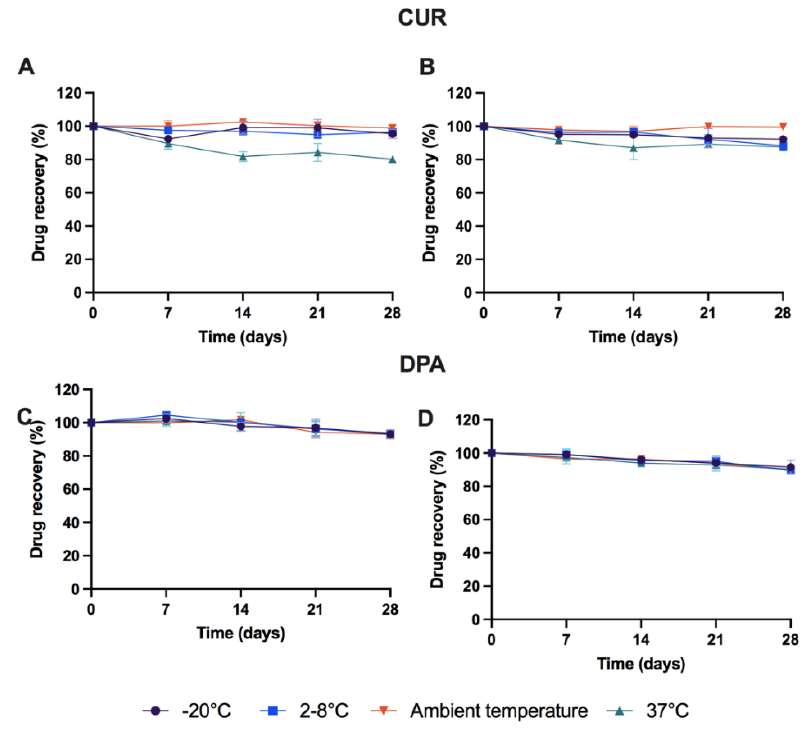
Figure 2. Percentage recovery of CUR: ( A ) PBS pH 7.4 containing 0.5% w / v Tween ® 80; ( B ) PBS pH 7.4 containing 0.5% w / v Tween ® 80 and 0.1% w / v AA; DPA in ( C ) PBS pH 7.4 containing 0.5% w / v Tween ® 80; ( D ) PBS pH 7.4 containing 0.5% w / v Tween ® 80 and 0.1% w / v AA after different conditions over 30 days (means ± SD, n = 3).